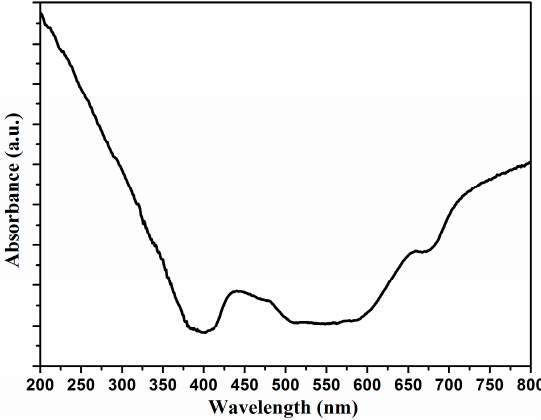
Figure 4. UV-Vis diffuse reflectance absorption spectra of the annealed Ti-Ni-Si-O photoanode. The photoelectrochemical water splitting behavior of Ti-Ni-Si-O nanostructures is shown in